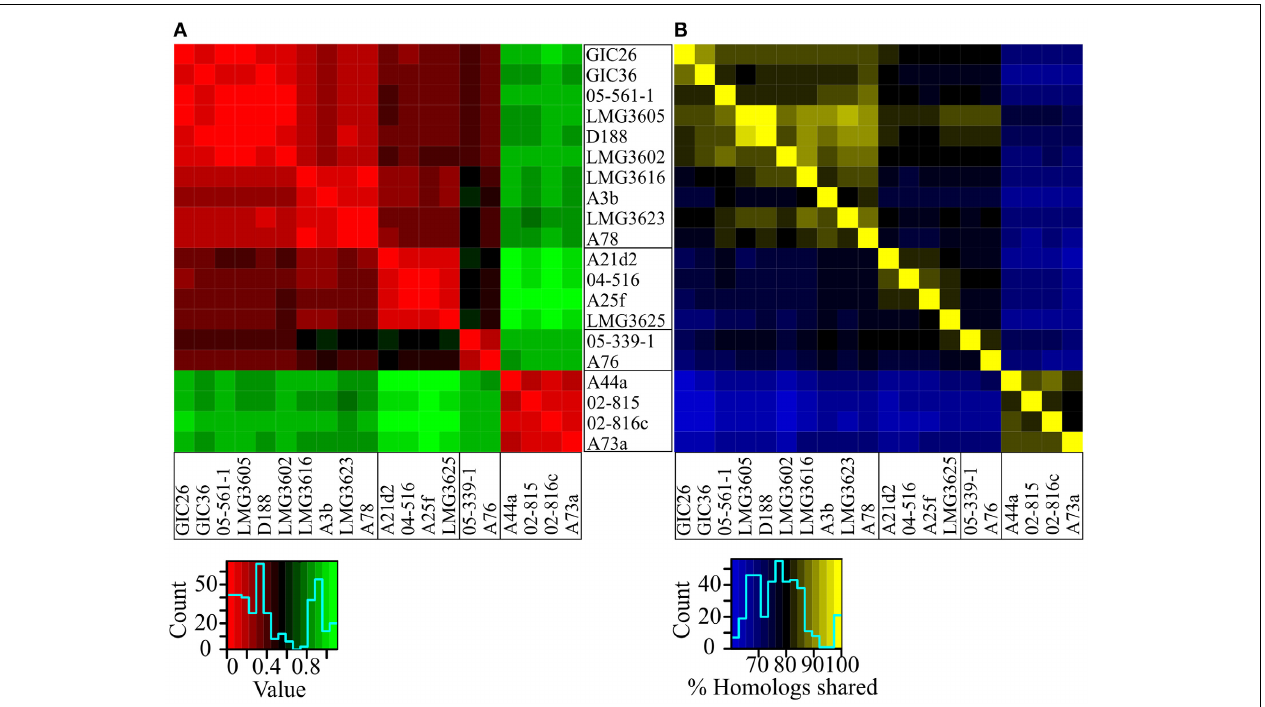
FIGURE 3 | Heatmaps of codon usage preference and homology. (A) Codon usage preference similarities were calculated for all possible pairwise comparisons. Lower values indicate fewer differences. Isolates were ordered according to their phylogenetic relationships. (B)